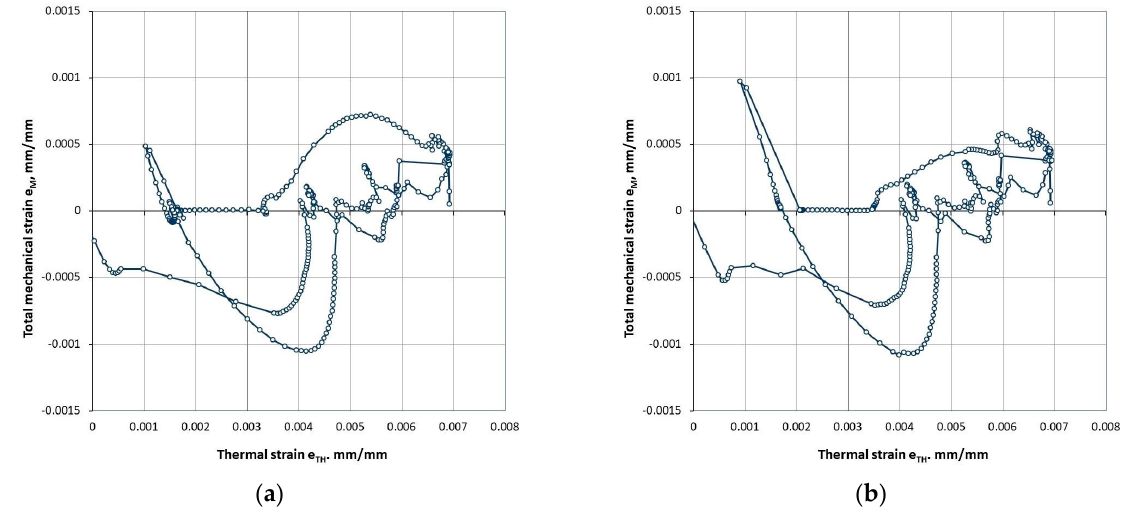
Figure 17. Normal “z” component of the total strain and stress tensors versus thermal strain (calculated for point A— Figure 14b; ( a ) obtained on the basis of calculations of the case of 1000 W/m 2 K, ( b ) obtained on the basis of calculations of the Nu number with local modification—3000 W/m 2 K.